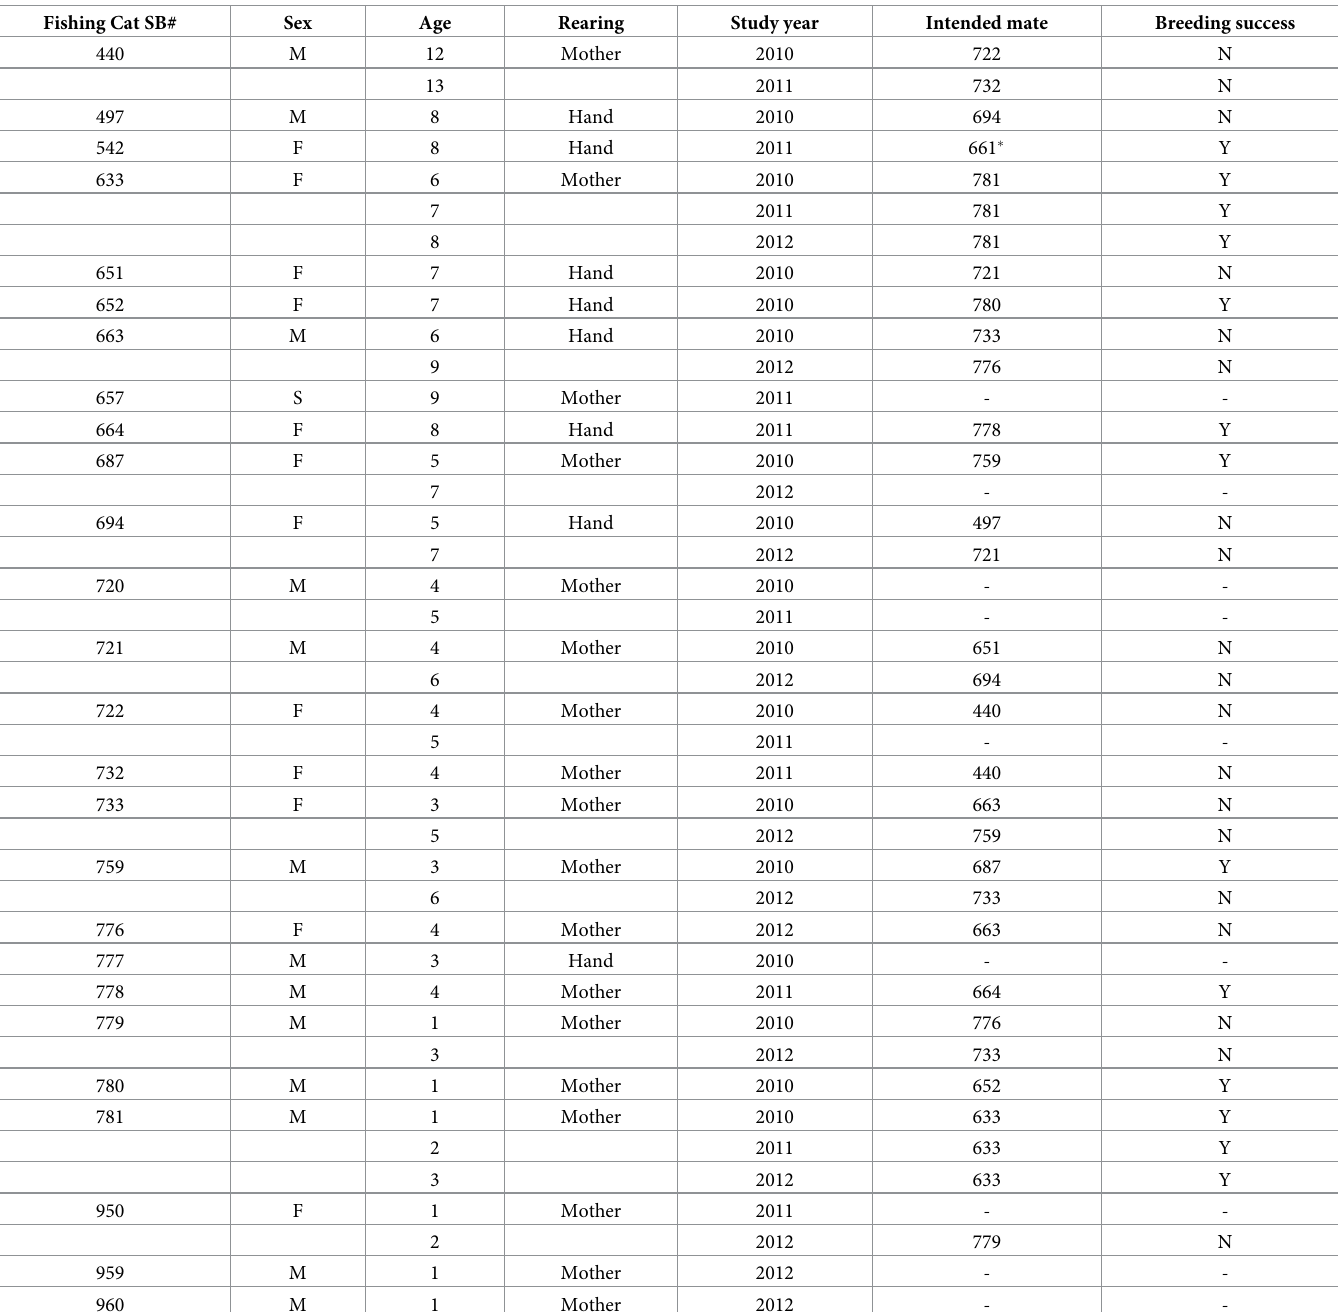
Table 1. Animal subjects. Studbook numbers (SB #) were used to identify individuals and mates were based on Species Survival Program recommendations. Age was determined at the start of the study for each cat. Rearing is listed as either mother—raised by the dam or hand—raised by humans at any time prior to weaning. Breeding success was defined as copulations observed (Y) or no copulations observed (N). All individuals were sexually mature at the time of the study. Fishing Cat